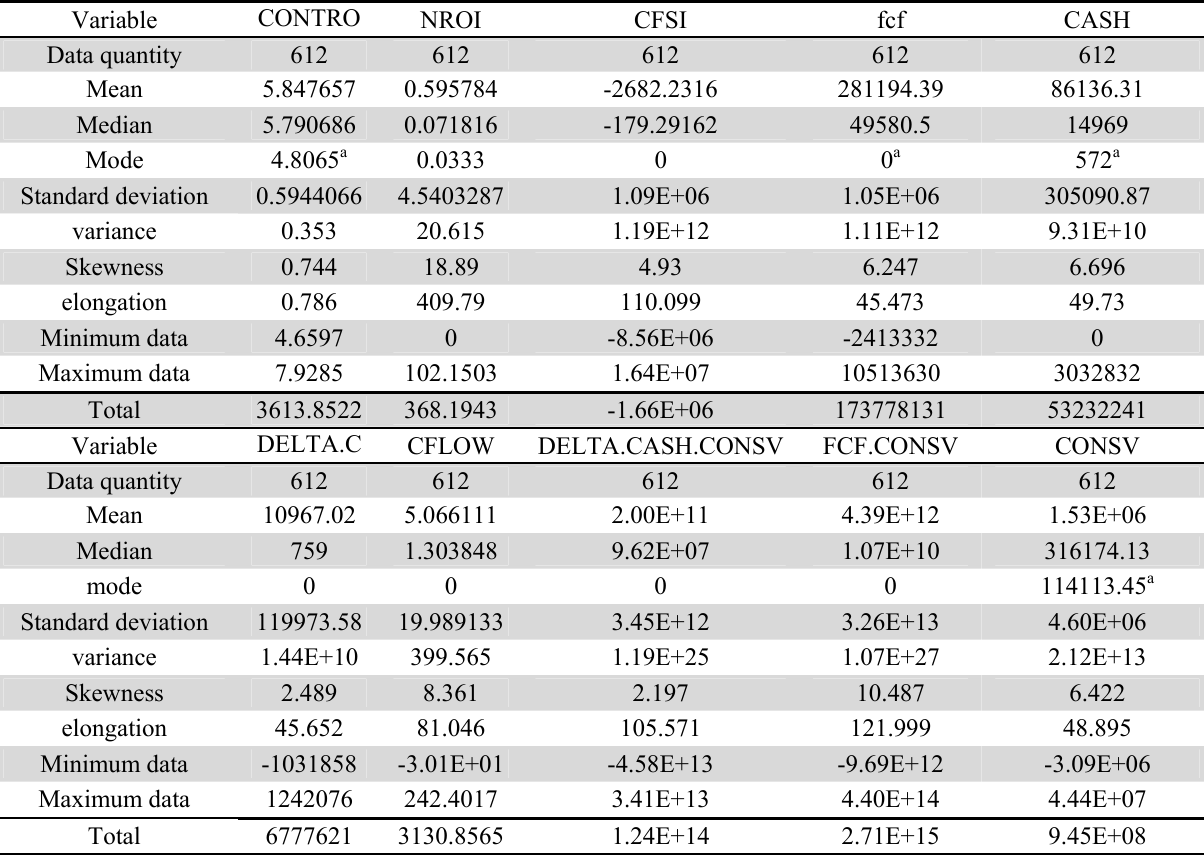
The summary of some basic statistics